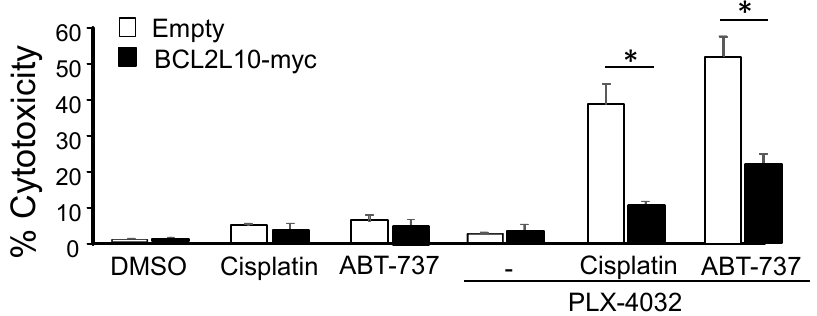
Figure 7. BCL2L10 protects melanoma cells from cell death upon treatment with PLX-4032 plus cisplatin or ABT-737. M2-empty and M2-BCL2L10-myc were treated for 48 h with the indicated drugs at the following concentrations: PLX-4032, 1 µ M; cisplatin, 10 µ M; ABT-737, 2.5 µ M. The percent of cytotoxicity was determined by using a crystal violet cytotoxicity assay. Bar graph shows the mean ± SD (from three independent experiments) of the percent of cytotoxicity. The statistical analysis is described in Methods. *: p <